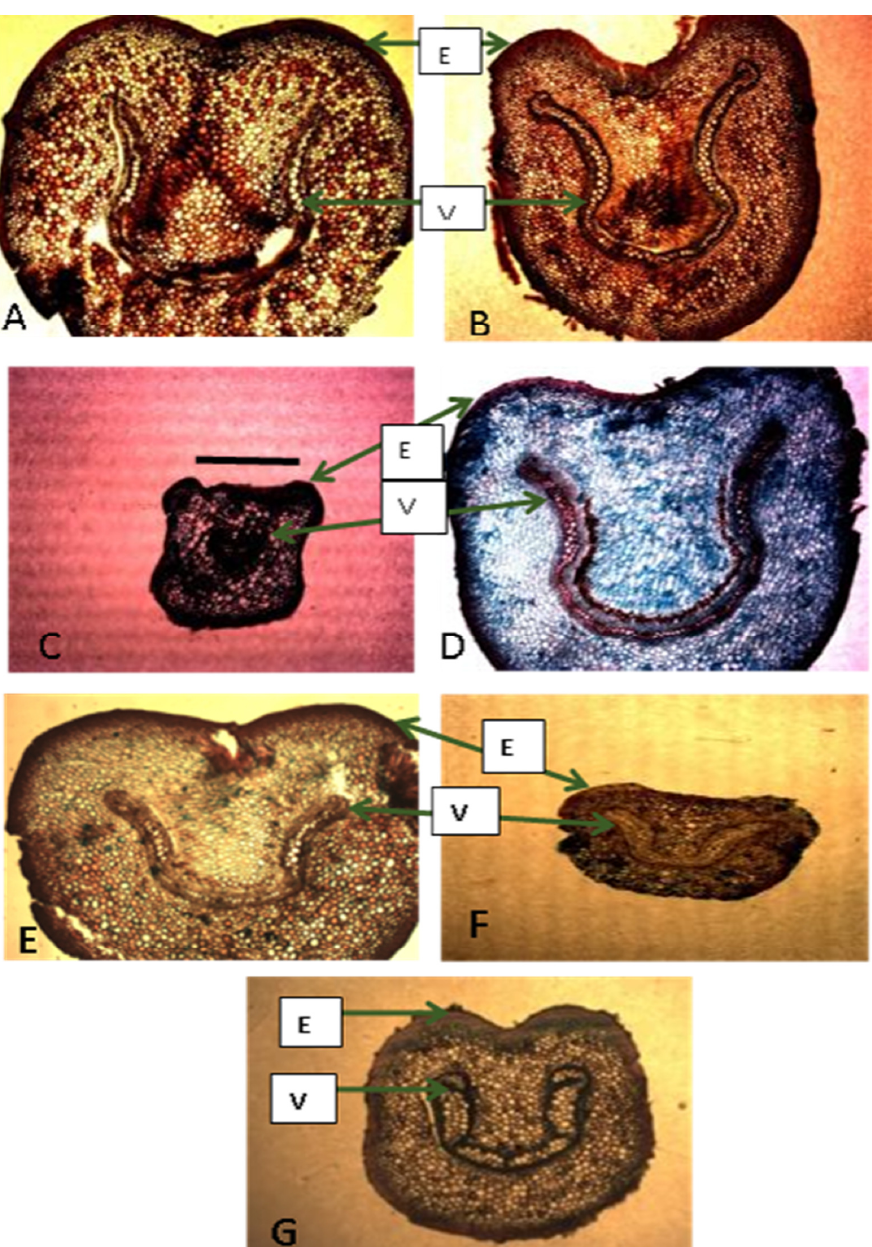
Figure 2. Transverse sections of the median regions of stipes showing outlines in seven species of Pteris studied. A: P . acanthoneu , B: P.atrovirens , C: P. ensiformis and D: P. mildbraedii, E: P similis , F: P.togoensis and G: P. vittata Legend : EP: Epidermis; VB: Vascular bundle, Bar = 1000